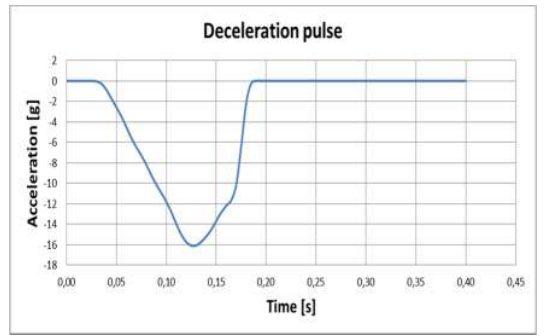
Figure 3. Deceleration pulse.